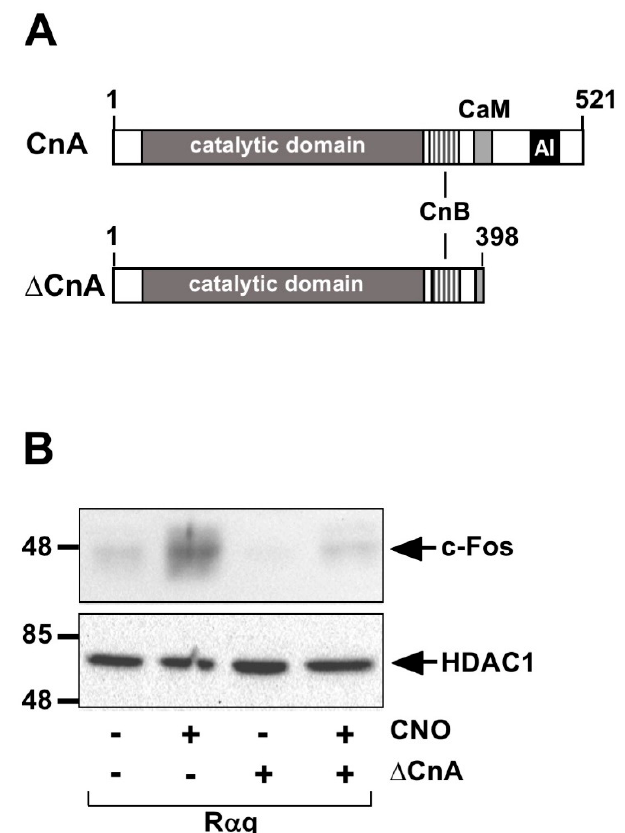
Figure 8. Calcineurin dephosphorylates and inactivates Elk-1. ( A ) Modular structure of calcineurin A and the truncated mutant ∆ CnA, which is constitutively active because the autoinhibitory domain (AI) and a portion of the calmodulin binding site have been deleted. ( B ) Stimulation of the G α q-coupled designer receptor (R α q) with CNO activates c-Fos expression in HEK293 cells. Expression of ∆ CnA attenuates receptor-induced c-Fos expression. HEK293 cells expressing R α q were infected with a lentivirus encoding ∆ CnA as indicated. Cells were cultured for 24 h in medium containing 0.05% serum and then stimulated with the R α q ligand CNO (1 µ M) for 3 h. The figure shows Western blot analysis of proteins of nuclear extracts using an antibody directed against c-Fos. The antibody directed against HDAC1 was used as a loading control. Reproduced with modifications from Ref. [57] with permission from Elsevier.